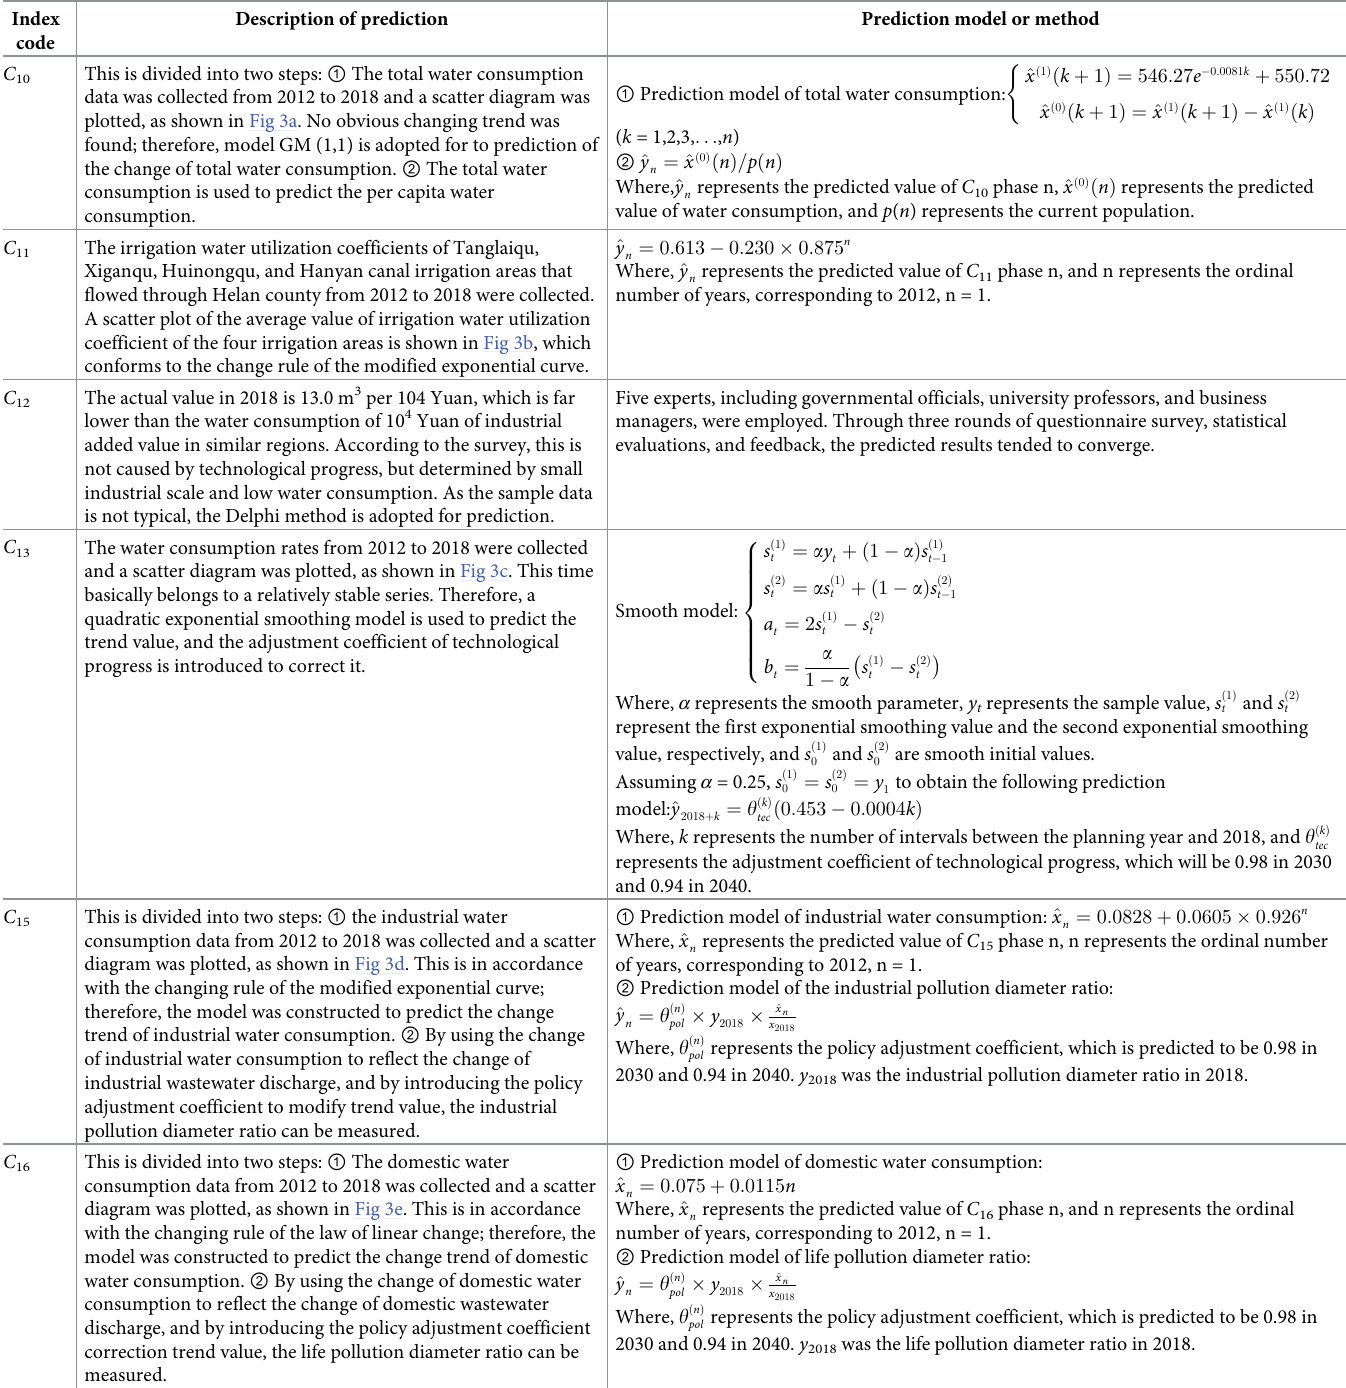
Table 4. Prediction description and prediction model or method of category B